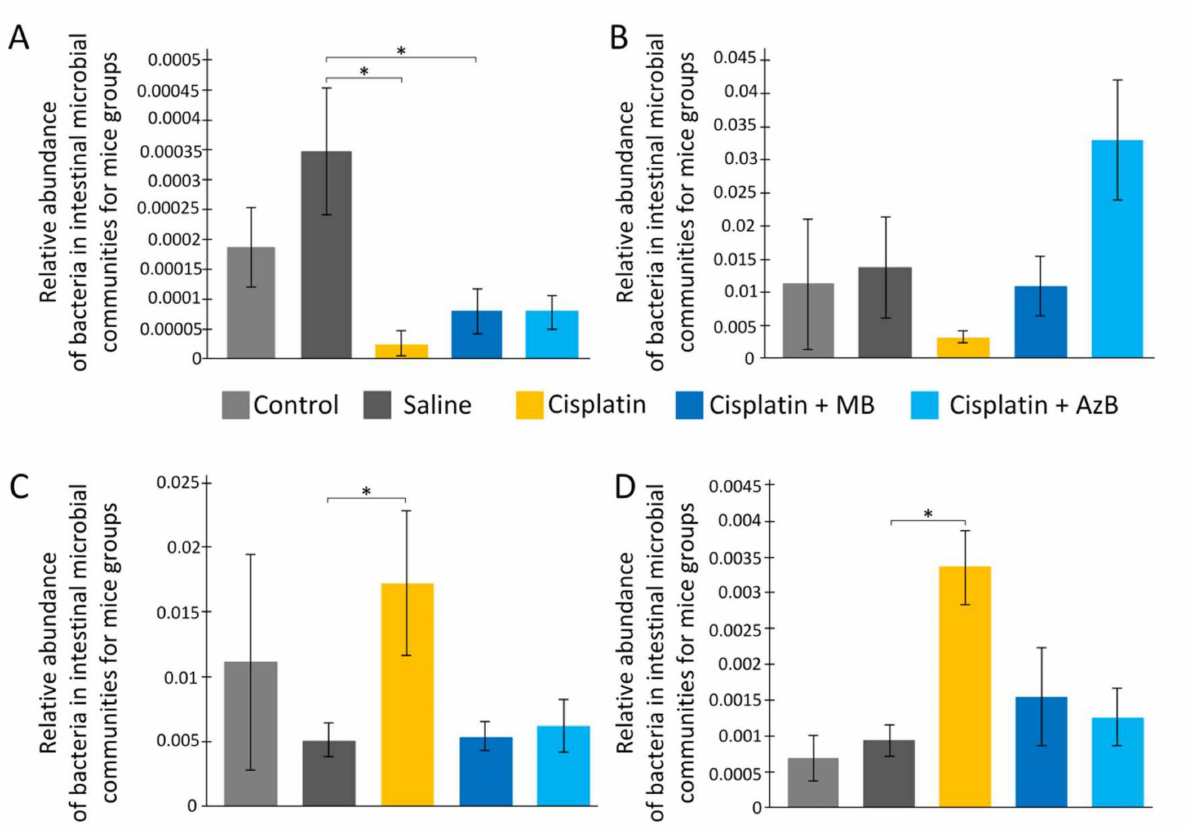
Figure 7. The content of predominant bacteria in the gut microbiome. ( A ) Actinotalea , ( B ) Prevotella , ( C ) Streptococcus , ( D ) Veillonella . * p < 0.05 comparison of the control group and treated groups using Tukey’s post-hoc